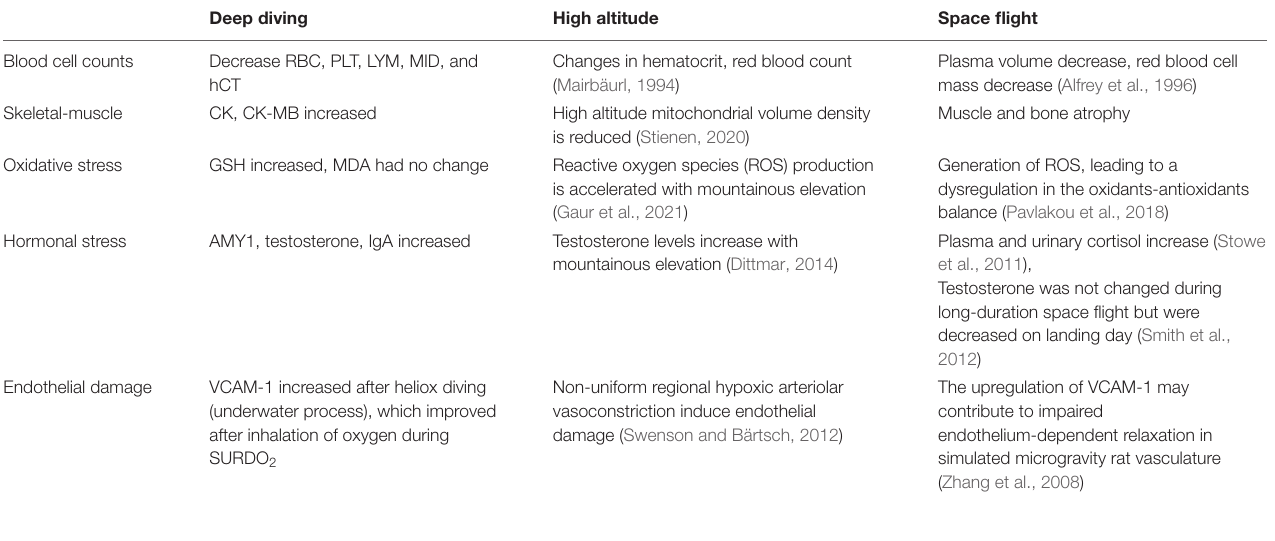
TABLE 1 | The impact of different extreme environments on physiological